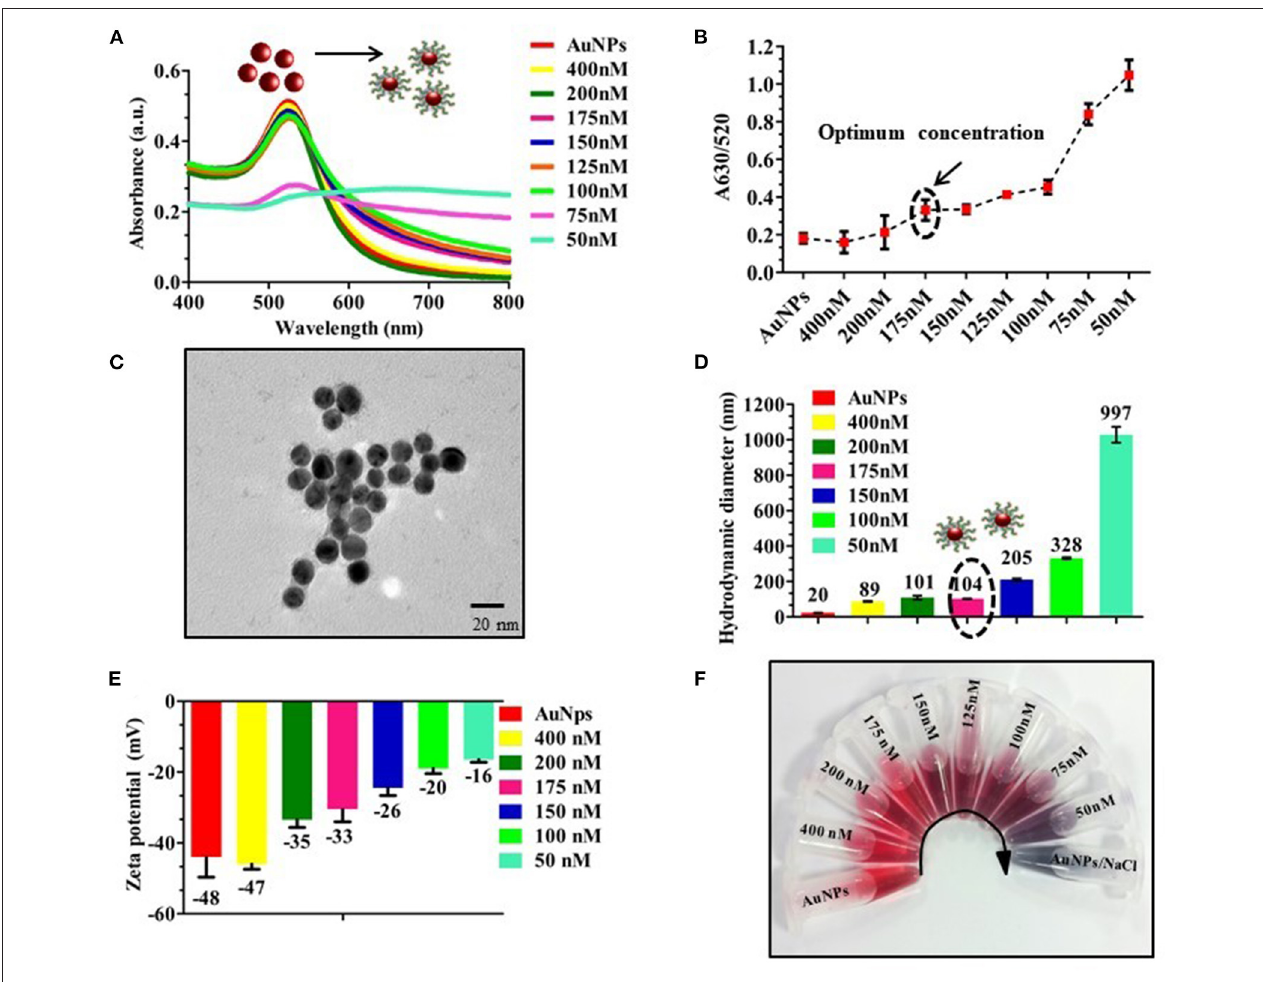
FIGURE 2 | Optimization of aptamer concentration; (A) UV-vis spectra of different concentrations of OTA aptamers (400–50nM) with a fixed volume of AuNPs; (B) A 630 / 520 absorbance ratio indicating an increase in the aggregation with a decrease in the concentration of aptamer (175nM) in the presence of 40mM of NaCl; (C) TEM image of OTA aptamer coated AuNPs, a very thin layer of OTA aptamers was observed around AuNPs; (D,E) Hydrodynamic diameter and Zeta potential of different concentration of OTA aptamers (400–50nM) conjugated AuNPs; (F) Photographic image of the vials with different concentrations of OTA aptamers.